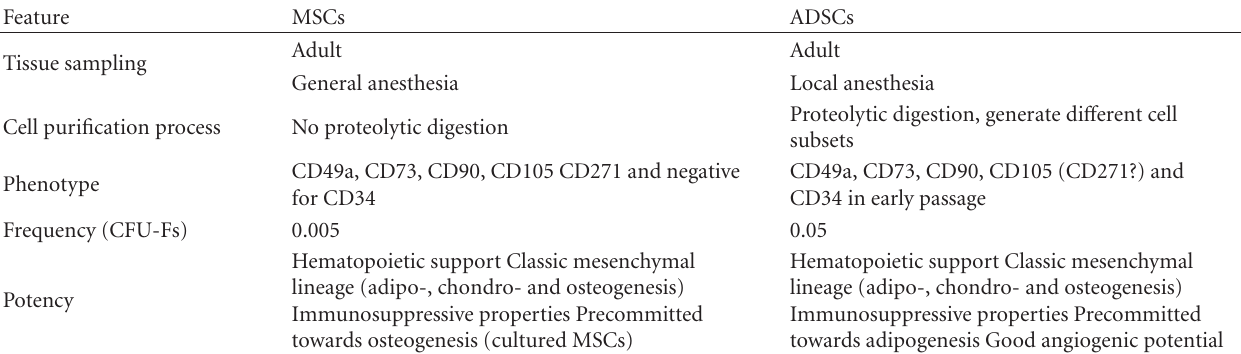
Table 1: Features of bone-marrow derived mesenchymal stem cells (MSCs) and adipose-derived stem cells (ADSCs).